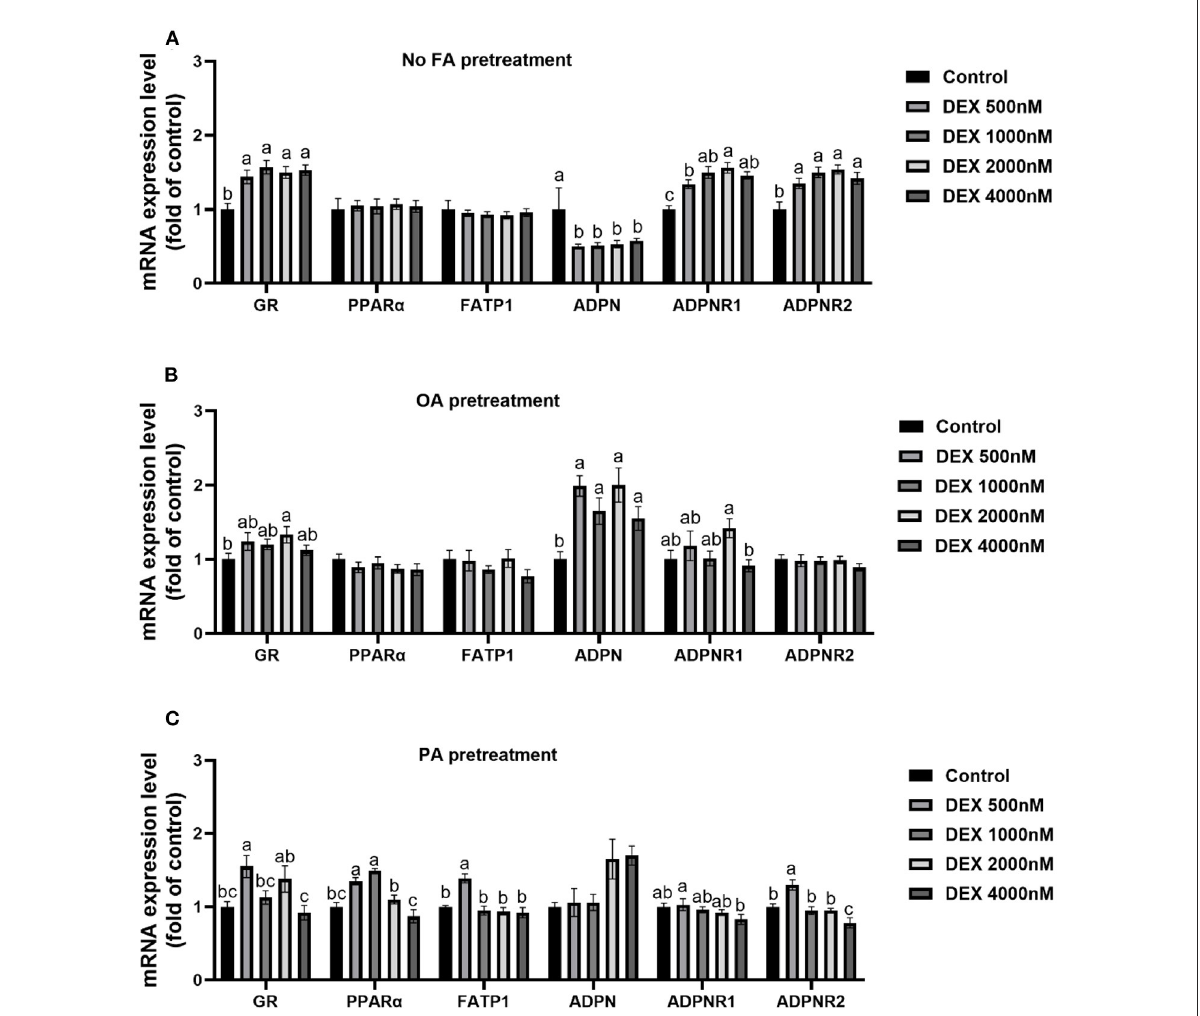
FIGURE4 Effects of dexamethasone on mRNA expressions of myoblasts pre-treated with different types of fatty acids or no FA pre-treatment. (A) Effects of dexamethasone on mRNA expression level of myoblasts without FA pre-treatment; (B) mRNA expression level in myoblasts cultured with OA supplementation medium; (C) mRNA expression level in myoblasts cultured with PA supplementation medium. Data are presented as the mean ± SEM ( n = 6). Different superscripts without common letters differ significantly ( P <